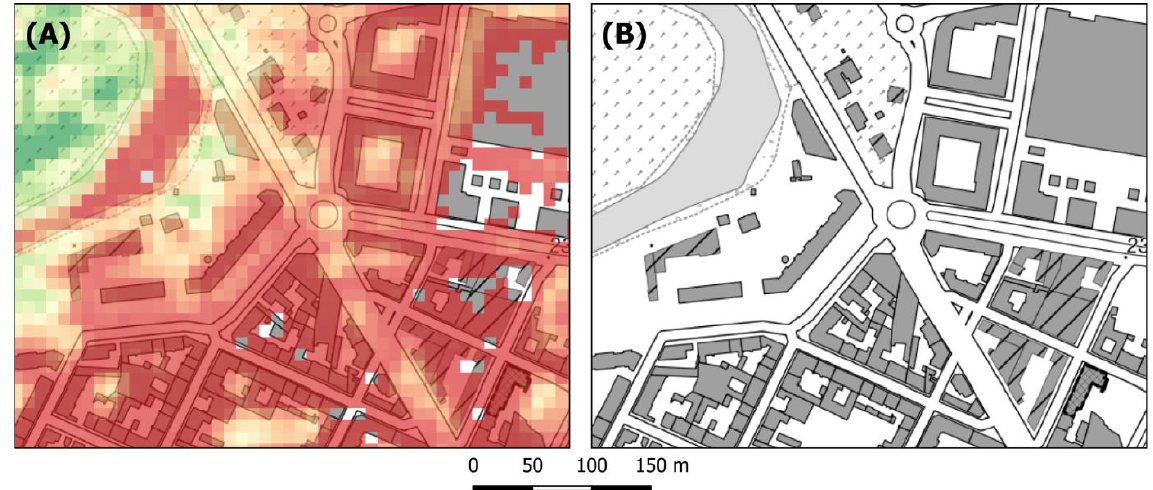
Figure 3. Examples of errors affecting HR-VPP metrics in terms of spatial consistency. Many pixels, mapped as “vegetated” in the HR-VPP dataset (where metric estimates are given), were erroneously assigned to built-up areas (grey polygons in ( B )). This demonstrates that the HR-VPP processing chain, as expected for all the automatized and general data processing, can contains errors that have to be preventively removed using existing auxiliary information. The base map in figure corresponds to the BDTRE 2019 available as WMS (Web Map Service) from the Piemonte Region Geoportal. Colored pixels in ( A ) refer about different values of the SPROD metric and are just used to show local inconsistencies of the HR-VPP dataset. No legend was therefore reported.